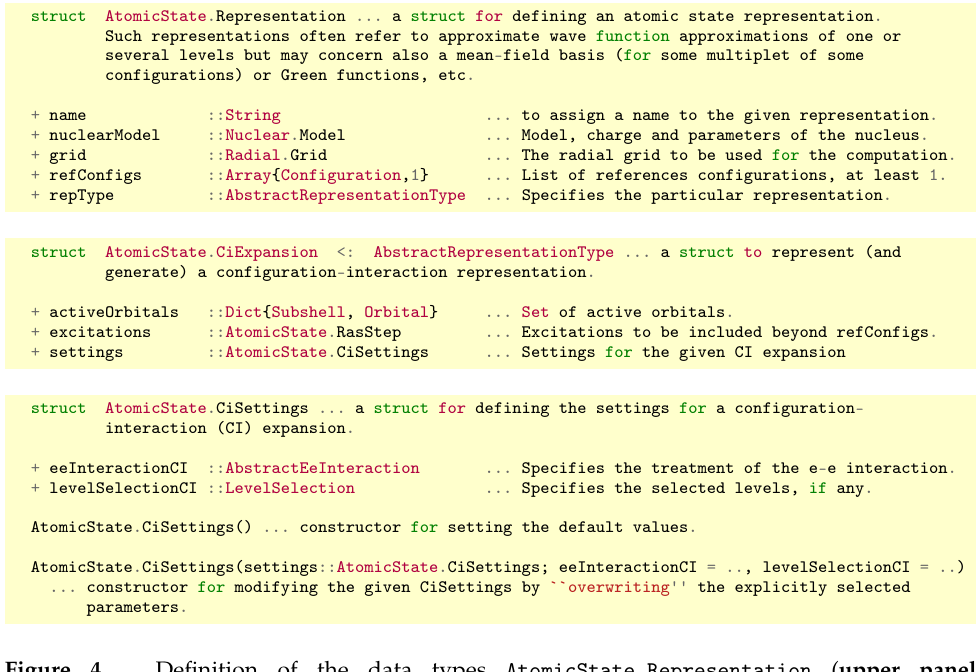
Definition of the data types AtomicState.Representation ( upper panel ), AtomicState.CiExpansion ( middle panel ) and AtomicState.CiSettings ( lower panel ) to select and perform a configuration interaction computation as discussed in the text. CI wave functions utilize a single step of a restricted-active-space (RAS) expansion and the associated virtual excitations that are to be applied with regard to the given reference